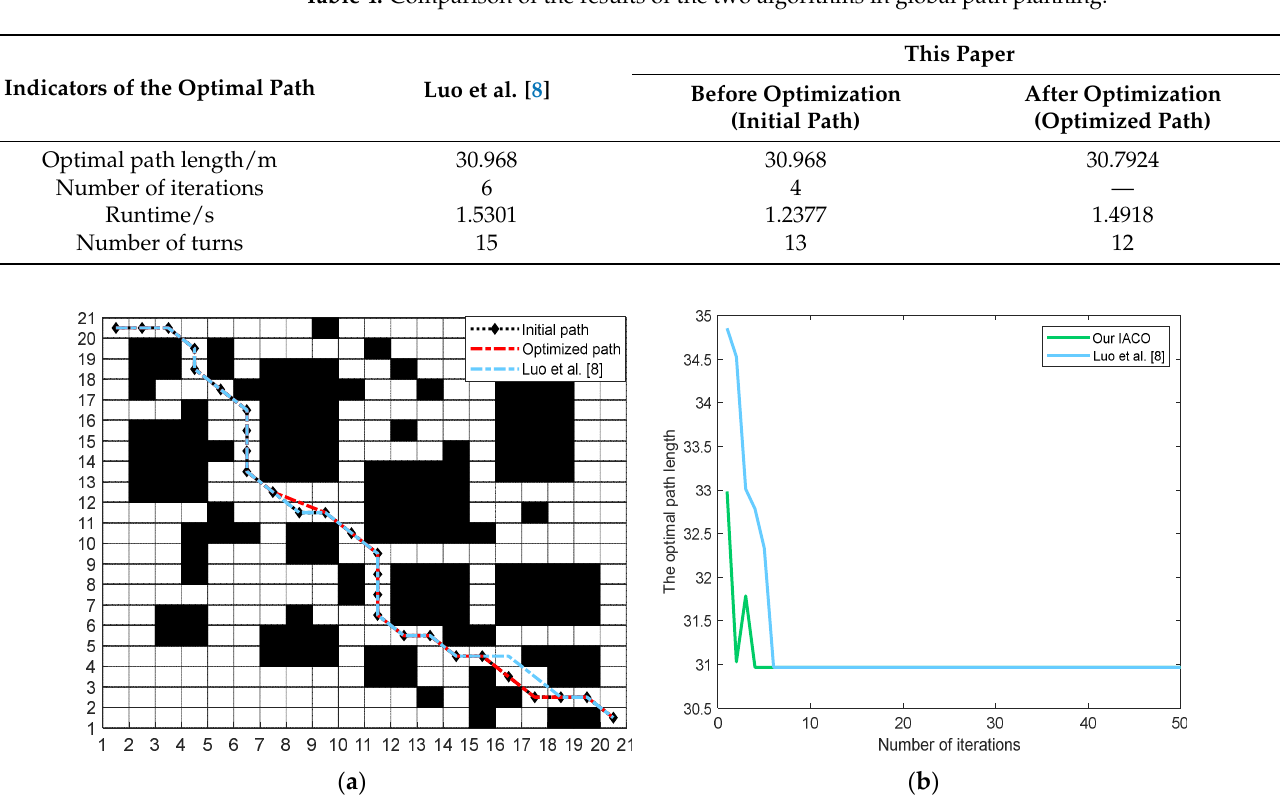
Table 4. Comparison of the results of the two algorithms in global path planning.